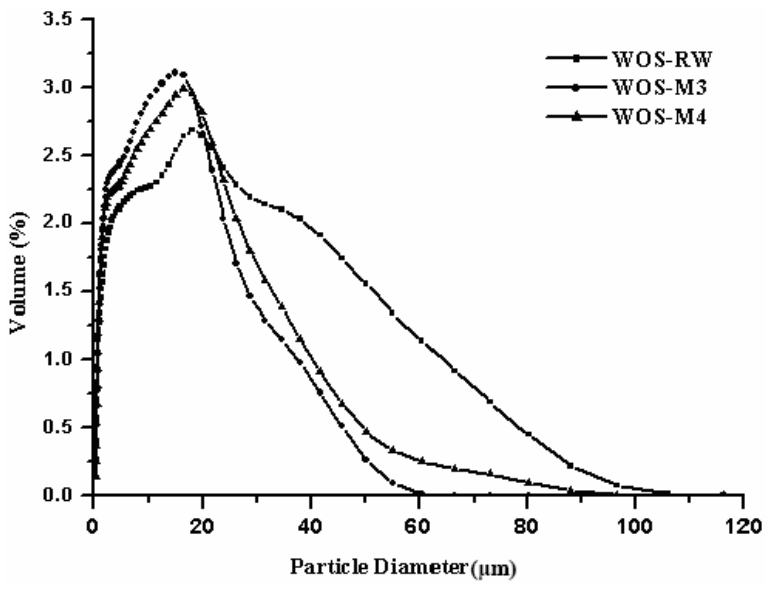
Figure 4. Particle size distributions of the crude oyster shell powder (denoted as WOS-RW) and some calcite-based powders ( i.e. , WOS-M3 and WOS-M4).